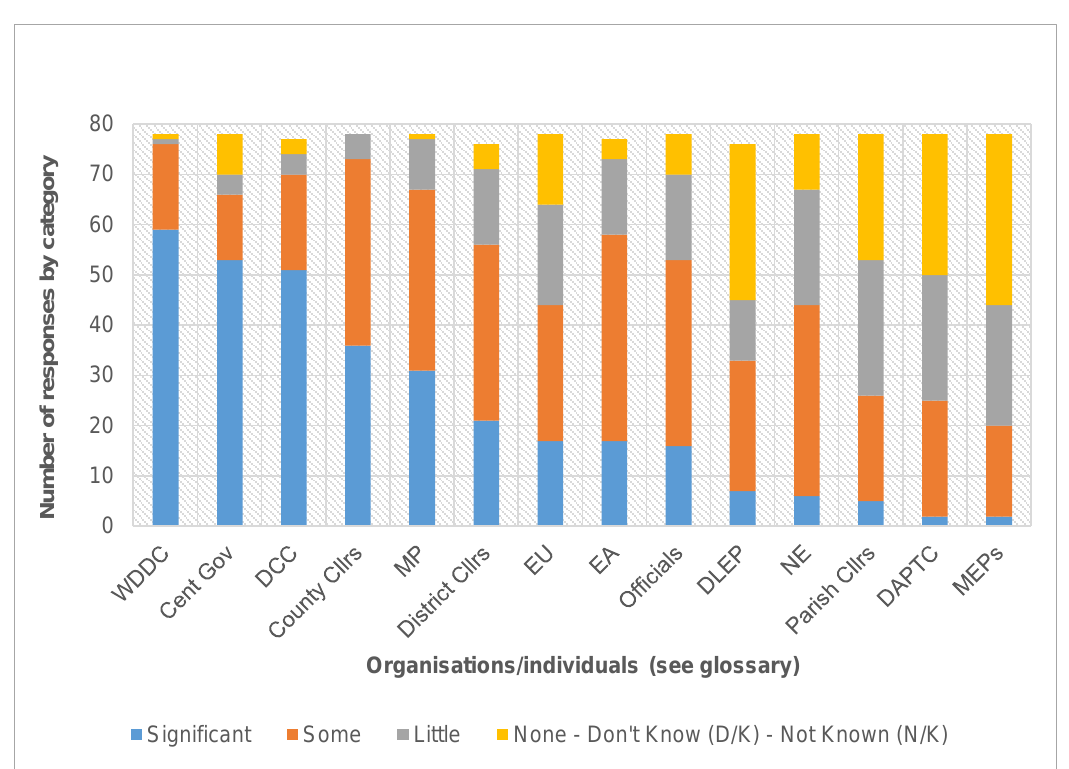
Figure 3: Participants’ assessment of loci of influence over rural policy in West Dorset